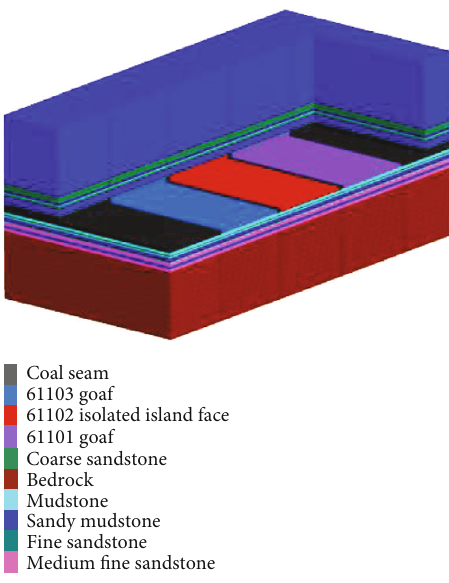
Figure 2: Numerical calculation